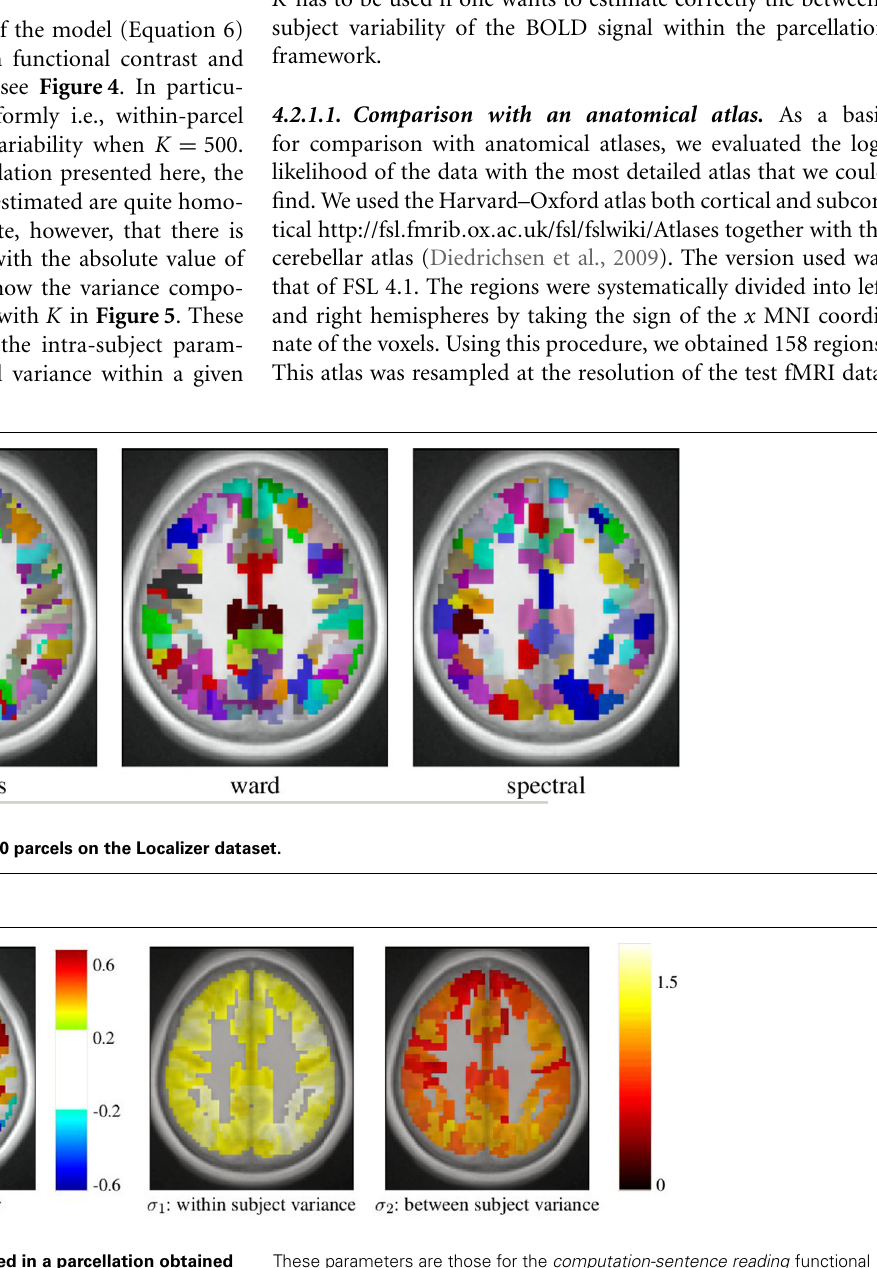
FIGURE 4 | Example of parameters estimated in a parcellation obtained with Ward’s clustering and K = 500 parcels. They are given in arbitrary units (percent of the baseline fMRI signal, squared for variance estimates).